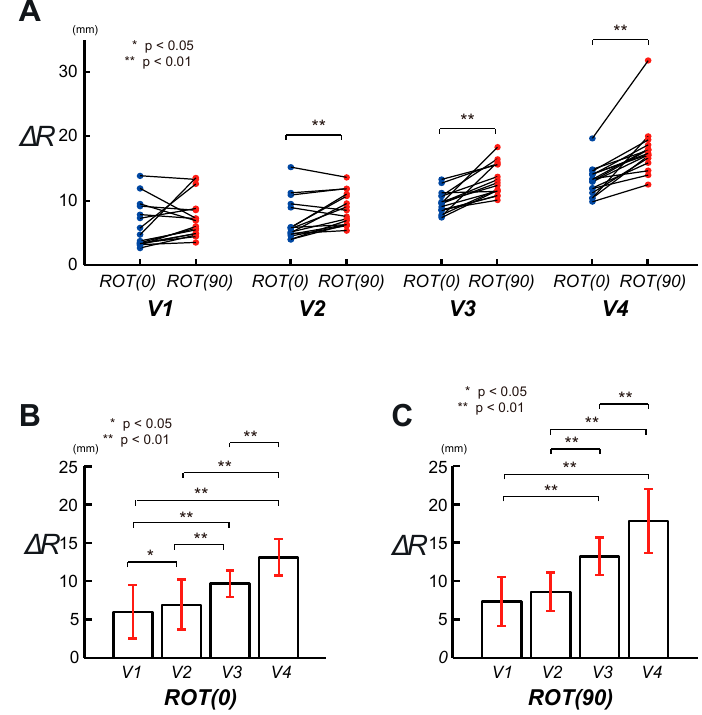
Figure 3. Evaluation of the circular tracking movement based on Δ R in 3D VR space. ( A ) The graphs indicate the pairwise comparison of Δ R analyzing the speed factor between ROT (0) and ROT (90). ( B ) The result of the pairwise comparison was indicated for Δ R , on the frontal plane ( ROT (0)), at four target speeds. ( C ) The pairwise comparison was displayed for Δ R , on the sagittal plane ( ROT ( 90 )), at four target speeds.